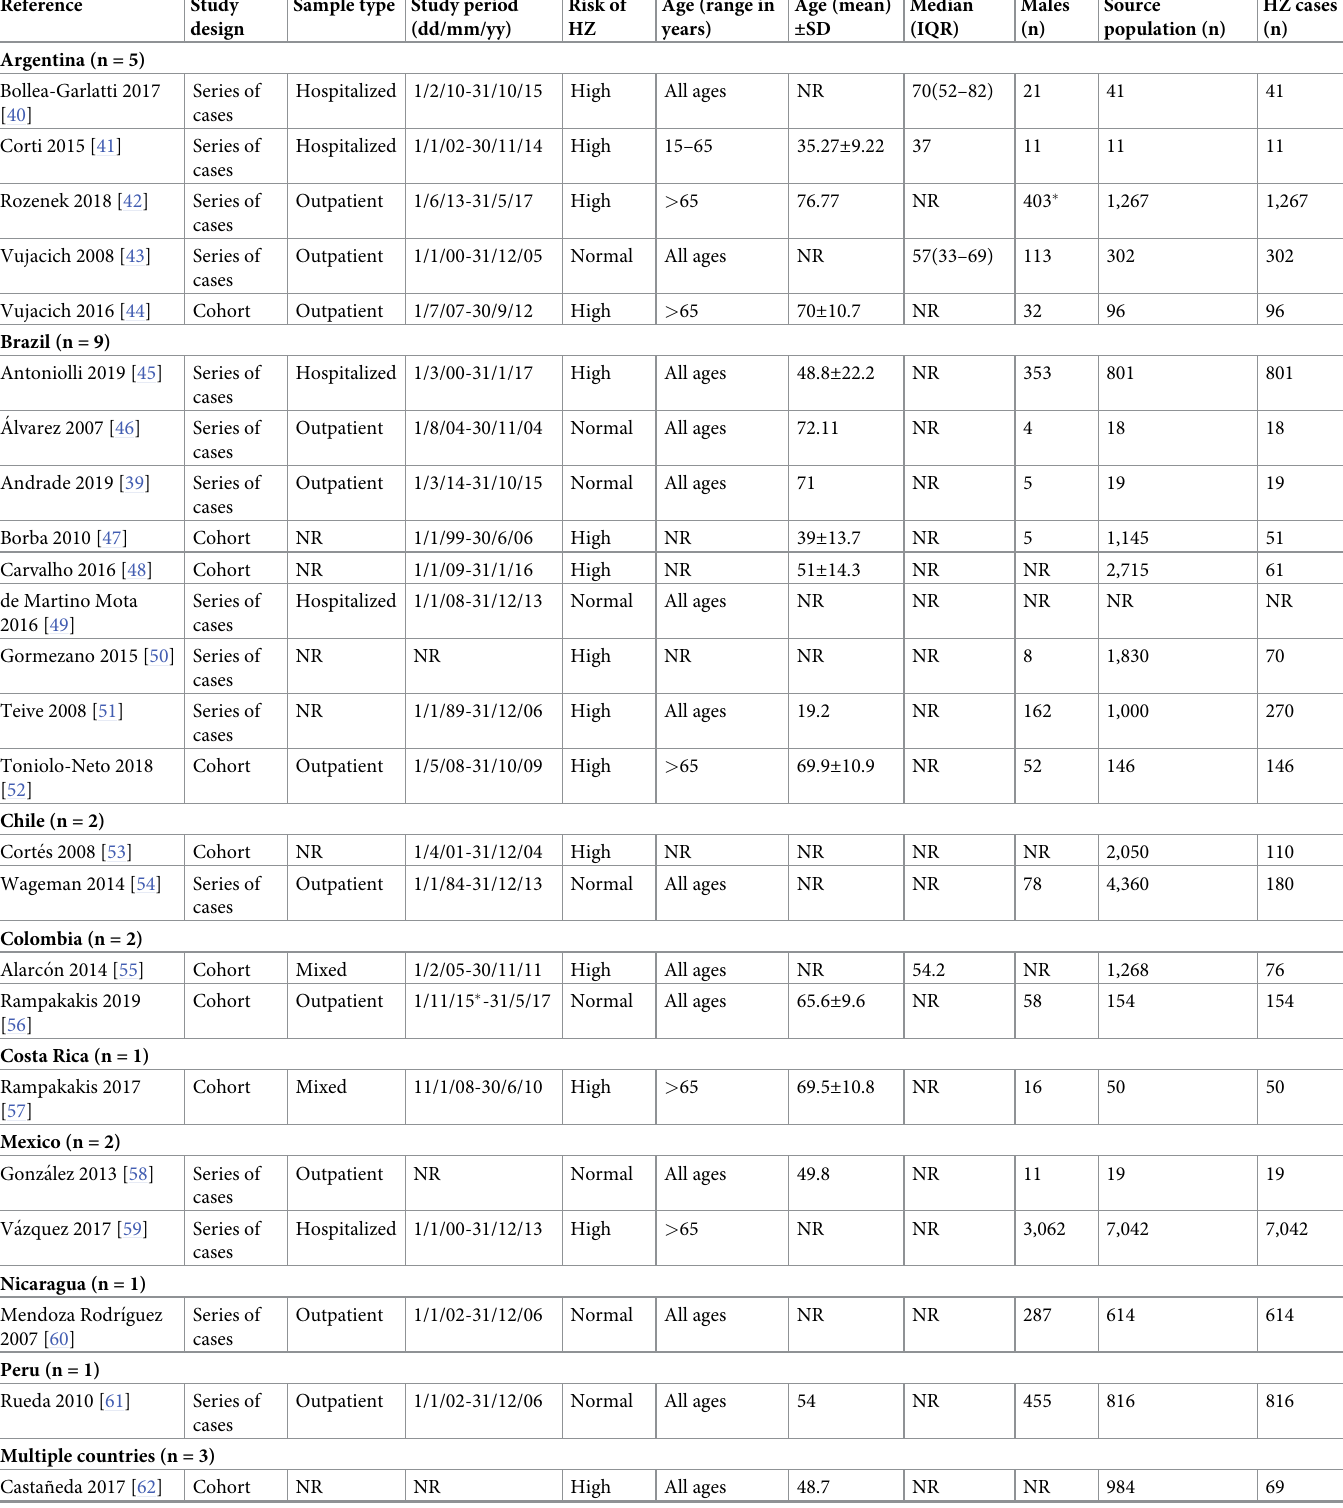
Table 2. Study and population